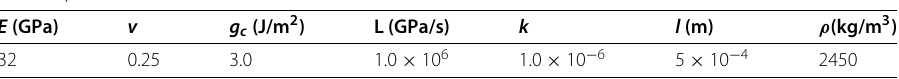
Table 4 Material properties used in the tensile dynamic fracture simulations, taken from (Borden et al. 2012)